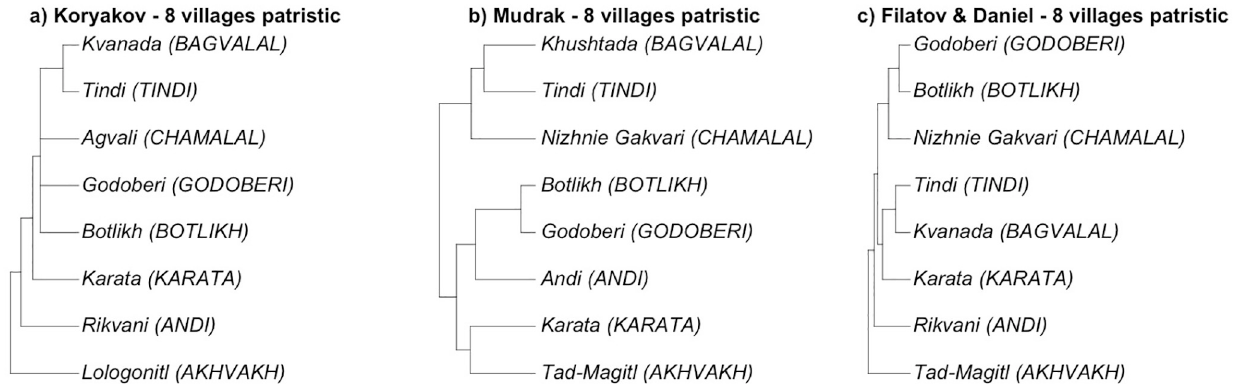
Fig 4. Quantitative lexicon-based phylogenies for Andic languages. Tree tips represent villages rather than languages, and branch lengths are a meaningful measure of the phylogenetic distance between languages. For each tree, eight villages are included (compare with Fig 3).